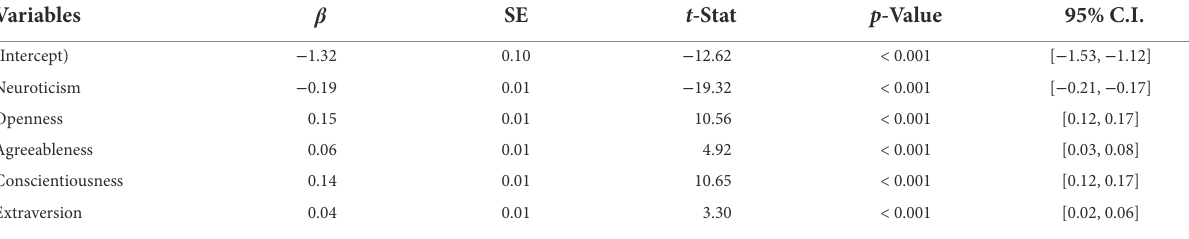
TABLE 4 Multiple regression analysis results for personality traits and overall satisfaction after factoring out